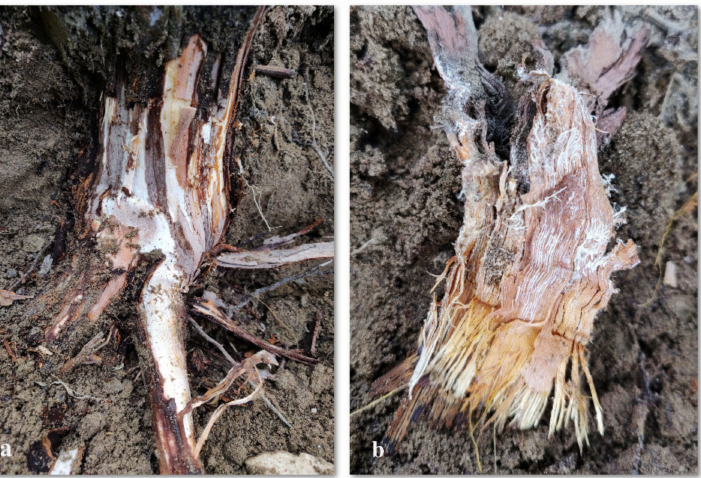
Figure 1. Underground symptoms of Armillaria root rot in grapevine. Panel ( a ) shows the rotting wood and whitish mycelium in the subcortical area of the collar; panel ( b ) shows the fan mycelium in a detached fragment of collar cortex. Photo from the author, Mezzolombardo, TN,